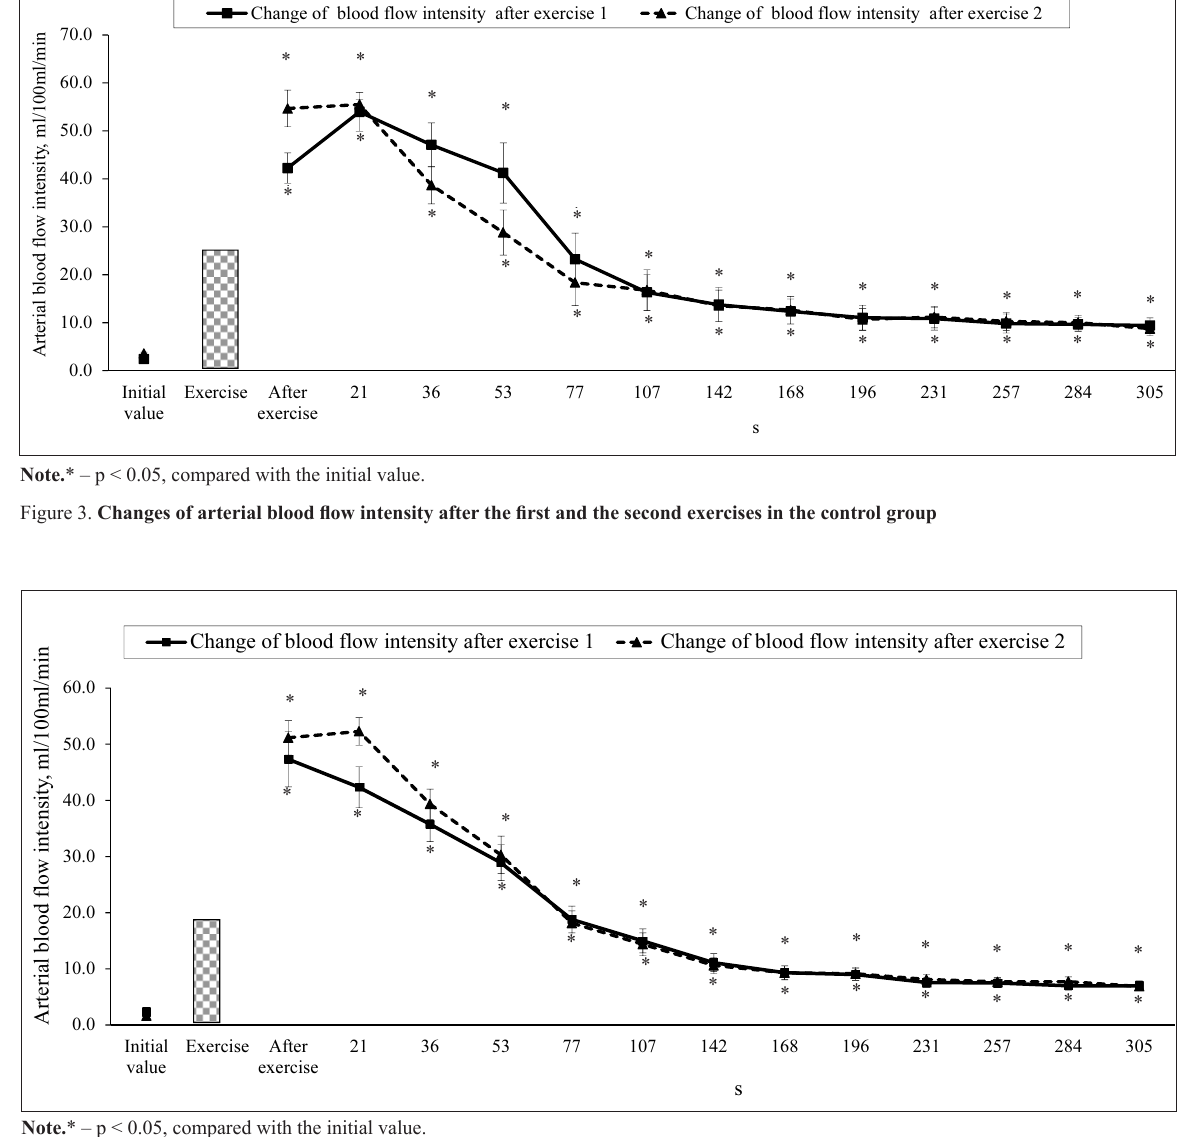
Figure 2. Changes of working capacity in control and experimental groups